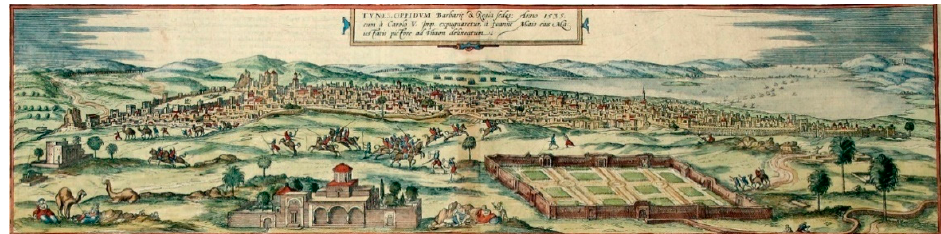
Figure 1. An overview representative image of the Medina in the 16th Century (data source: Atlas de Braum, 1575).